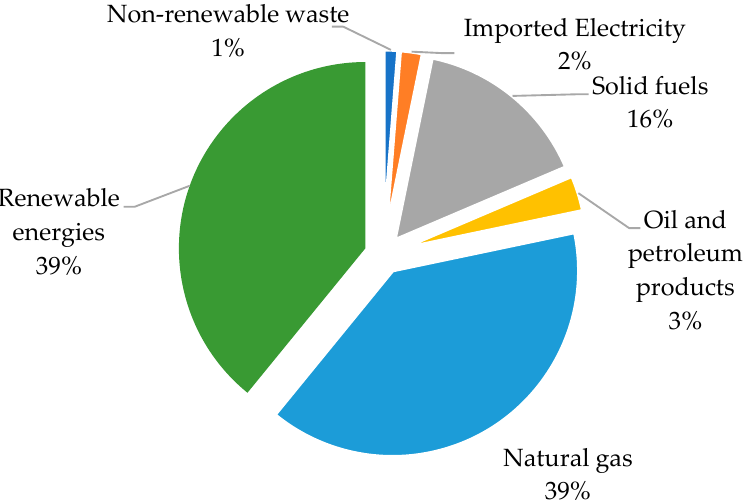
Figure 14. Fuels going into Portuguese electricity and heat generation–2019 data (adopted from Eurostat data).